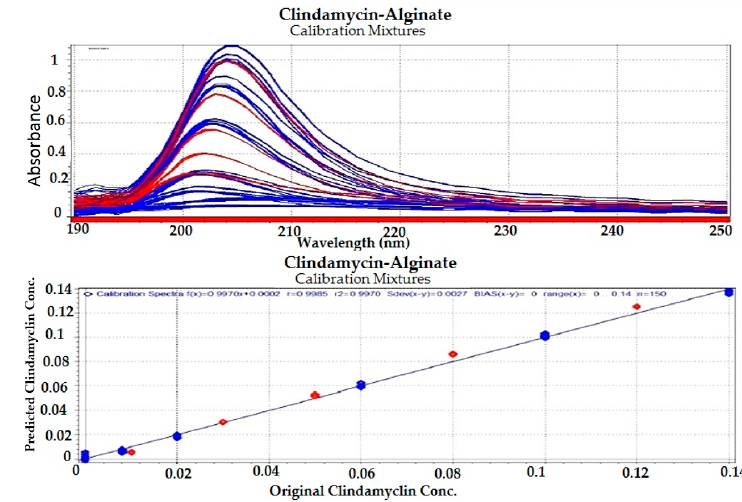
Figure 3. Regression plot for clindamycin concentration predicted by the model versus the known values in the calibration drug–alginate mixtures. Blue color for calibration set (C-set), while red color for validation set (V-set).